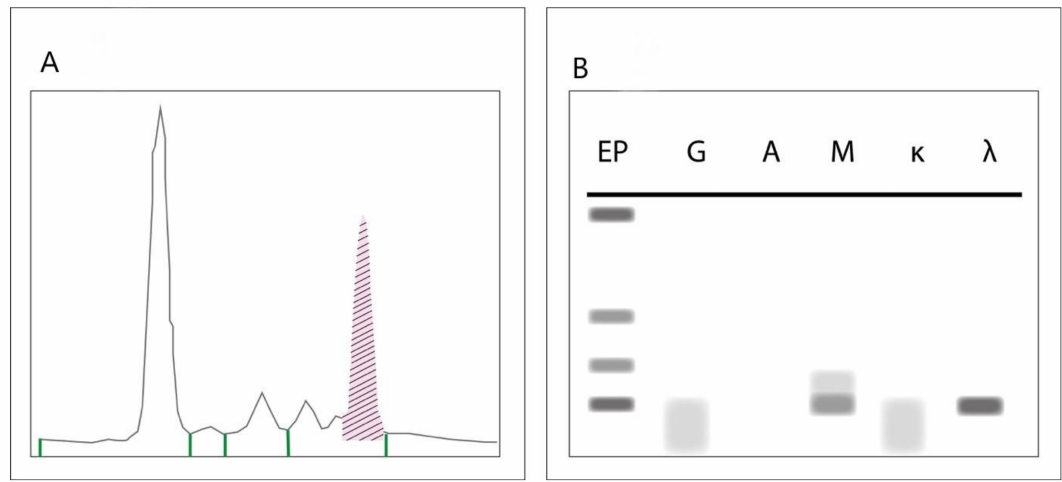
Figure 2. Typical findings on serum electrophoresis (SPEP) ( A ) and immunofixation electrophoresis (IFE) ( B ) indicative of an IgM paraprotein. The shaded area under the SPEP highlights the “spike” characteristic of monoclonal proteins. The discrete bands on IFE confirms clonality and the isotype as IgM